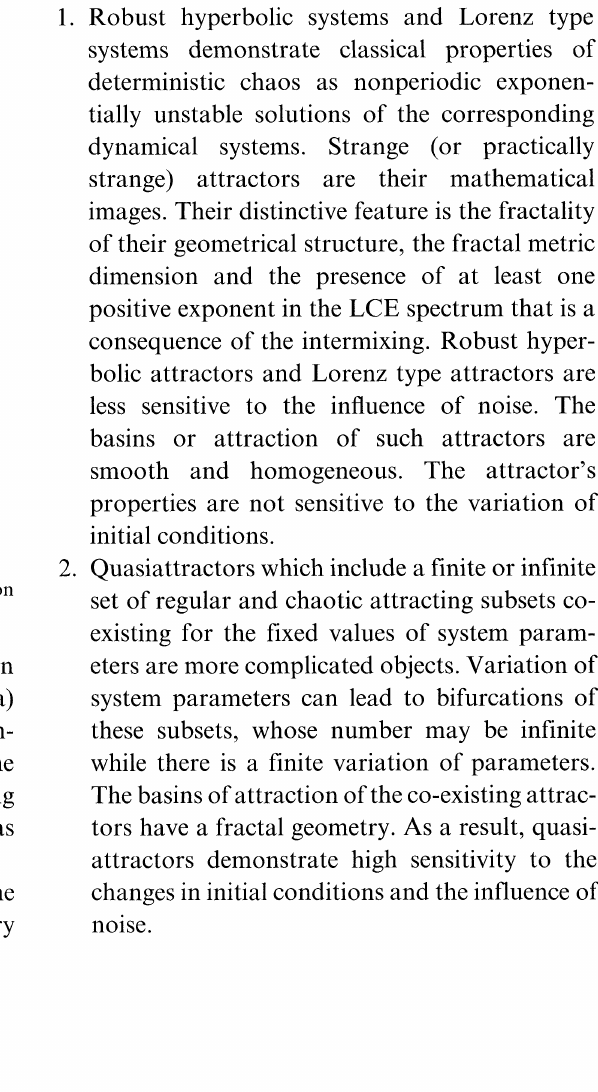
FIGURE 16 Singular-continuous spectrum of SNA in the map (12) for A-- 1.5.